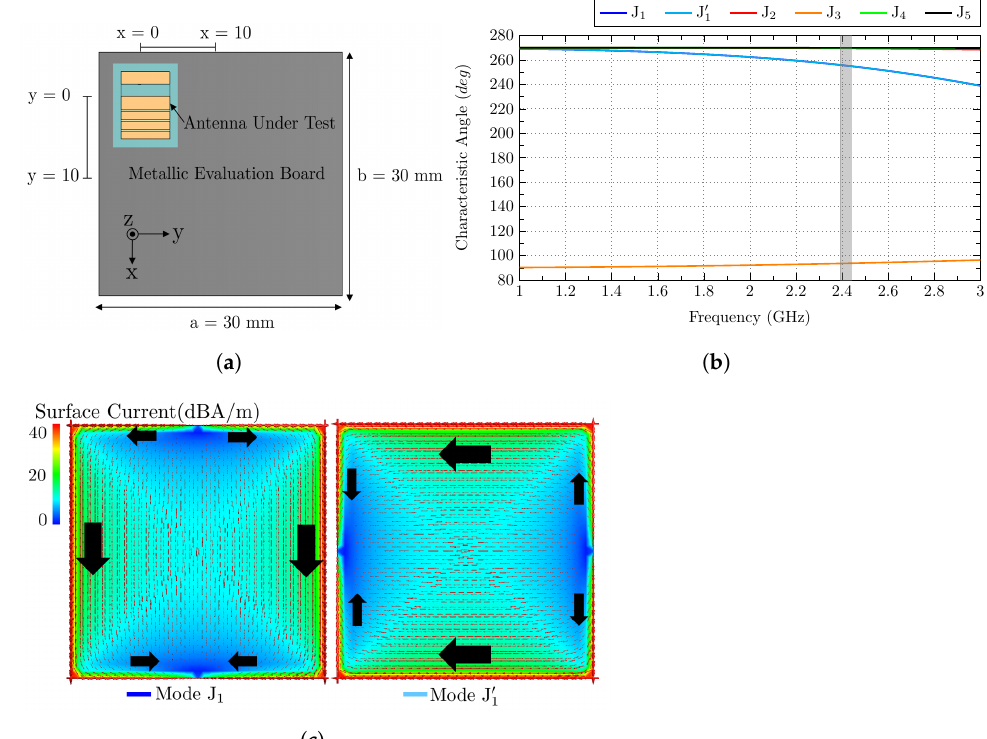
Figure 6. ( a ) Analyzed ground plane of 30 30 mm 2 with the antenna at four different positions × on the ground plane, ( b ) characteristic angles of the isolated ground plane modes (J 1 –J 5 ) with the operating frequency band colored in gray, and ( c ) current distribution of mode J 1 and J (cid:48) of the isolated 1 ground plane. Black arrows describe the direction of the